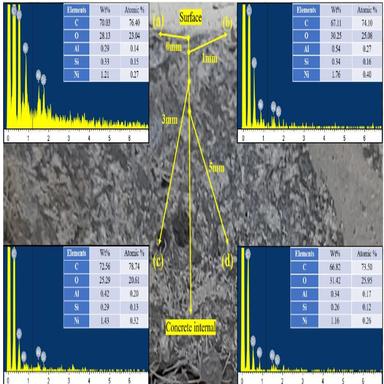
EDS spectra of superhydrophobic concrete at different depths. (a) Surface, (b)depth of 1 mm, (c) depth of 3 mm and (d) depth of 5 mm.